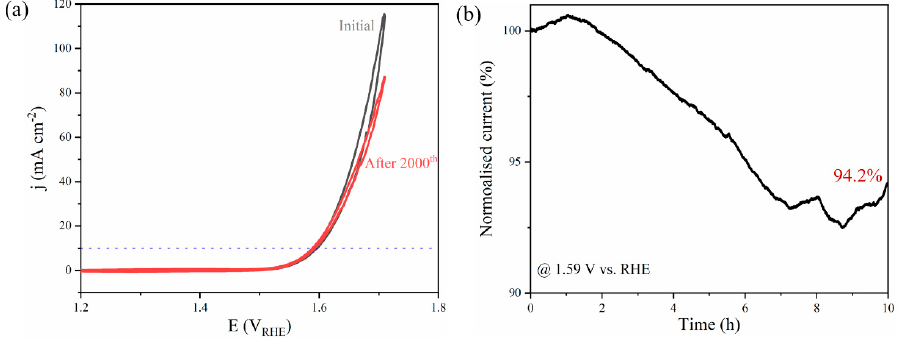
Figure 4. Stability tests for the FeCoNiCuIr HEA NPs using ( a ) CV cycling for 2000 cycles at a scan rate of 50 mV s − 1 and ( b ) chronoamperometry measurement at 1.59 V RHE in N 2 -saturated 1 M KOH.